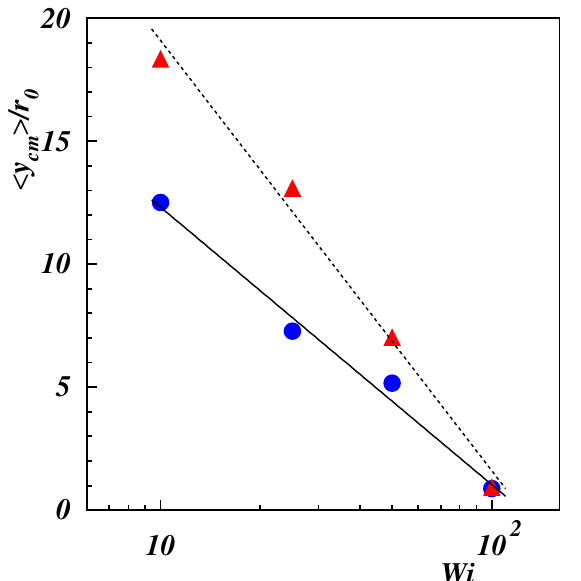
Figure 6. Average position along the y -direction of the polymer center of mass as a function of the Weissenberg number for L p / L = 0.5 ( • ), 2 ( (cid:78) ). Lines are the fits < y cm > / r 0 ∼ β ln Wi with β = − 4.9 ± 0.4 (full line) β = − 7.6 ± 0.6 (dashed